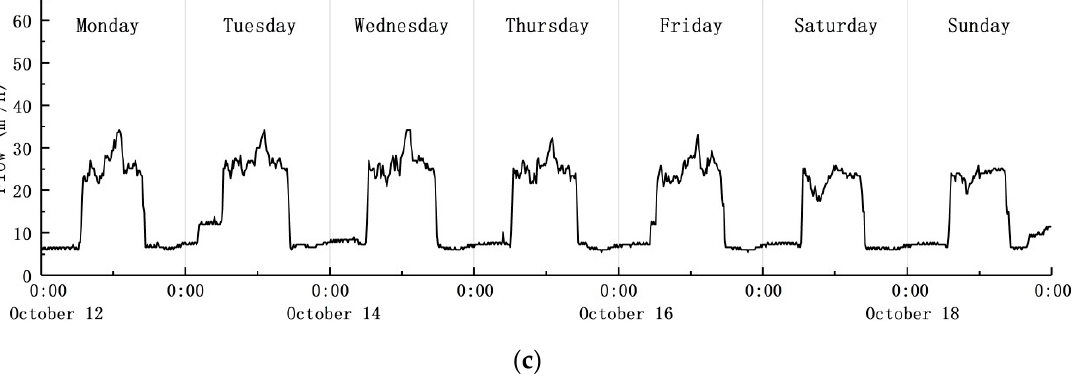
Figure 3. Ten-minute accuracy of water consumption curves of three users in a week: ( a ) a commercial user; ( b ) a residential user; ( c ) an industrial user.